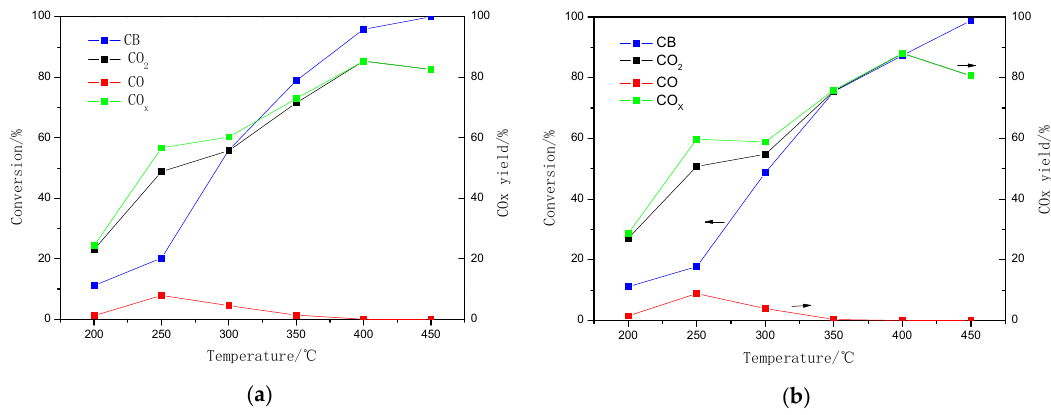
Figure 13. The CO x selectivity over Pd-Ce/TiO 2 catalysts. ( a ) 0.2% Pd /TiO 2 ; ( b ) 0.2% Pd 0.5% Ce/TiO 2 .